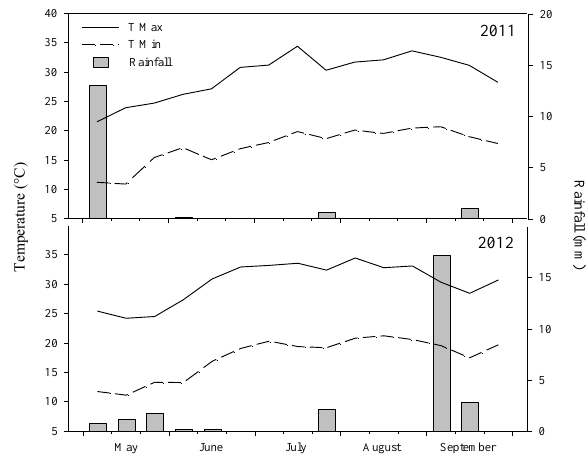
Figure 1. Meteorological data during the guar study period in 2011 and 2012, Ispica, Sicily.